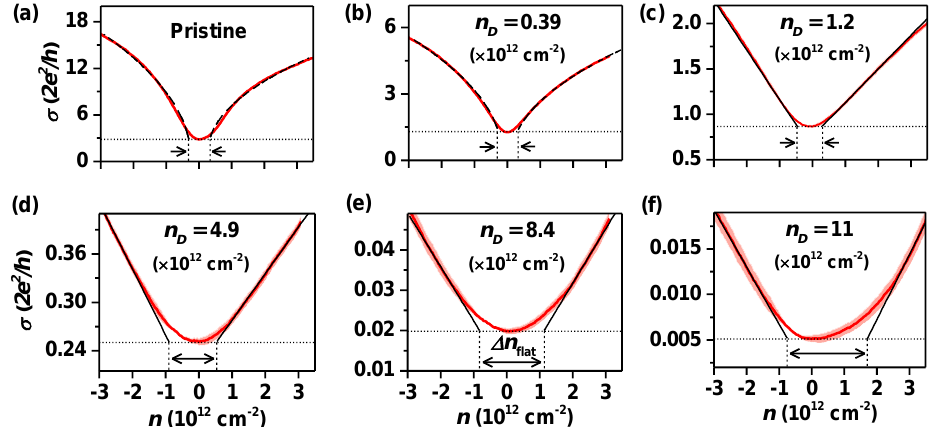
Figure 2. Transfer curves of oxidized graphene FETs with different n D . The red shade shows the standard deviation of repeated measurements. ( a ) pristine graphene; ( b ) n D = 0.39 × 10 12 cm − 2 ; ( c ) n D = 1.2 × 10 12 cm − 2 ; ( d ) n D = 4.9 × 10 12 cm − 2 ; ( e ) n D = 8.4 × 10 12 cm − 2 ; ( f ) n D = 11 × 10 12 cm − 2 . Black dotted lines show the minimum conductivity σ min . Dashed lines in ( a , b ) are fits to σ ∝ and solid lines in ( c – f ) are linear fits to the transfer curves. With increasing n D , transfer curve becomes more flattened near n = 0, as indicated by the width ∆ n flat